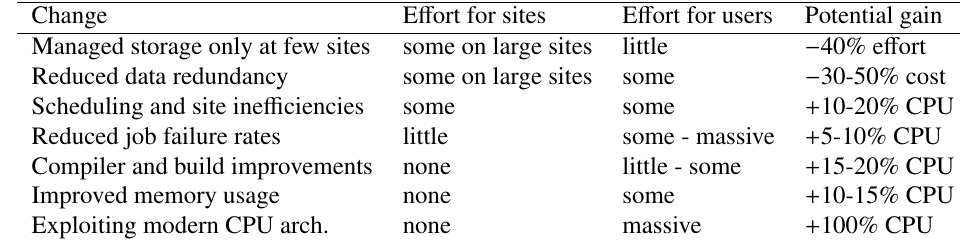
Table 2. Estimated potential gains and associate e ff